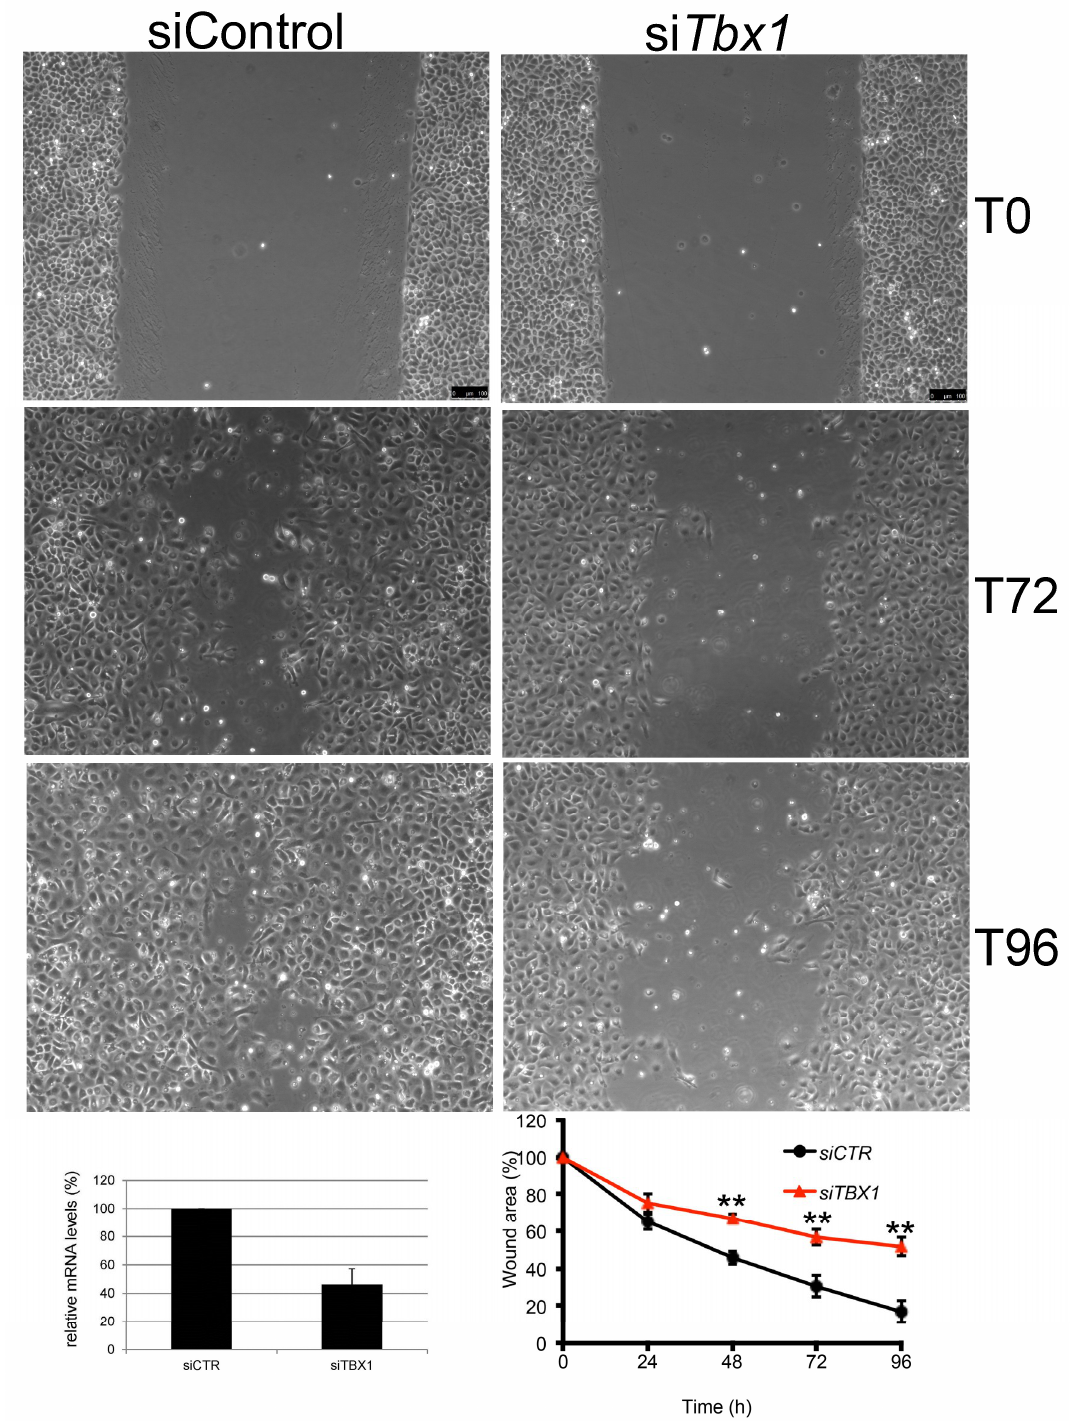
Figure 5. Wound healing assay with G2N2C cells. The phase contrast photographs show the wound at T0, T72, and T96 h in control (siControl) and Tbx1 knock down ( siTbx1 ) cells (scale bar: 100 μm). The histogram on bottom left shows the average of Tbx1 expression in four independent experiments used for the assay (individual numbers were 57%, 34%, 54%, and 40% of the control expression). The graph on the bottom right panel shows the scratch wound area as a percentage of the initial wound area determined using ImageJ software. The values are the means ± SD of four independent experiments (** p < 0.01). p -values for 48, 72, and 96 h are 0.0013, 0.006, and 0.0016, respectively.